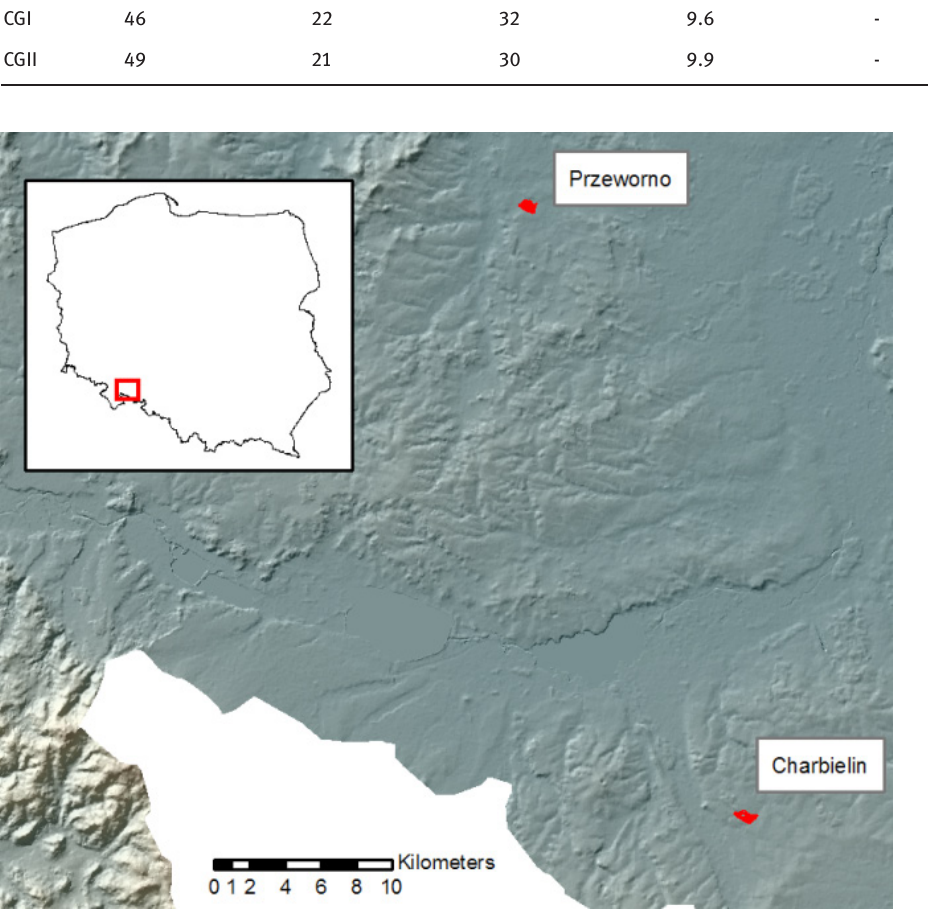
Przeworno - light soil